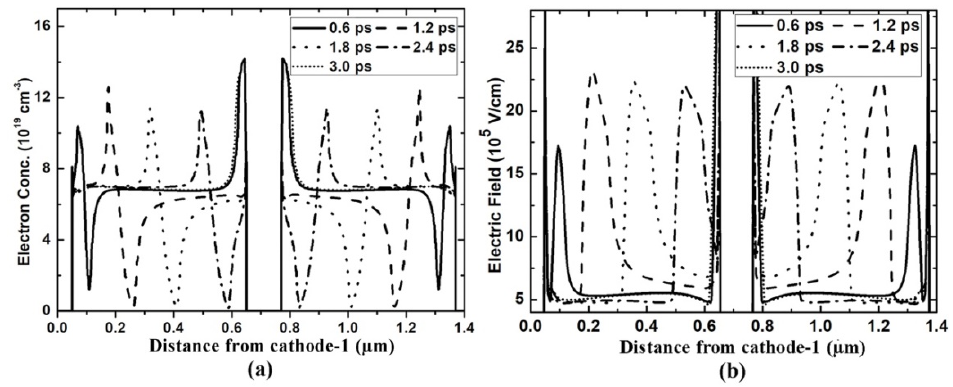
Figure 6. ( a ) Electron concentration and ( b ) Electric field profiles in one oscillation period in the grooved-anode diode as L = 1.2 µm.